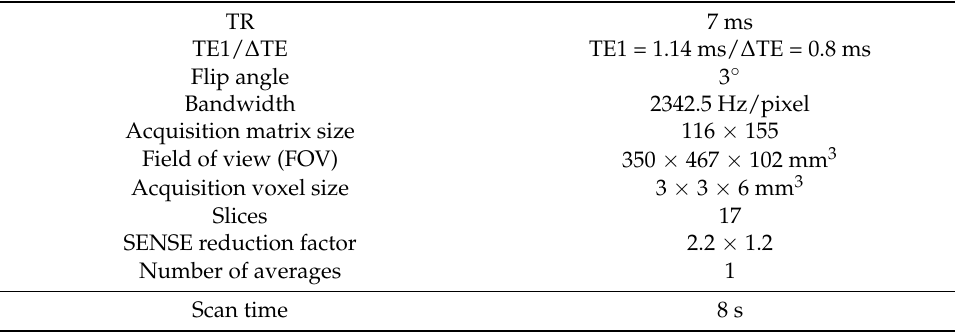
Table 1. MRI sequence parameters for six-echo multi-echo gradient echo acquisition. Scan parameters per stack, a total of four stacks were performed each scan. MRI: magnetic resonance imaging, TR: repetition time, TE: echo time, SENSE: sensitivity encoding for accelerated MRI.